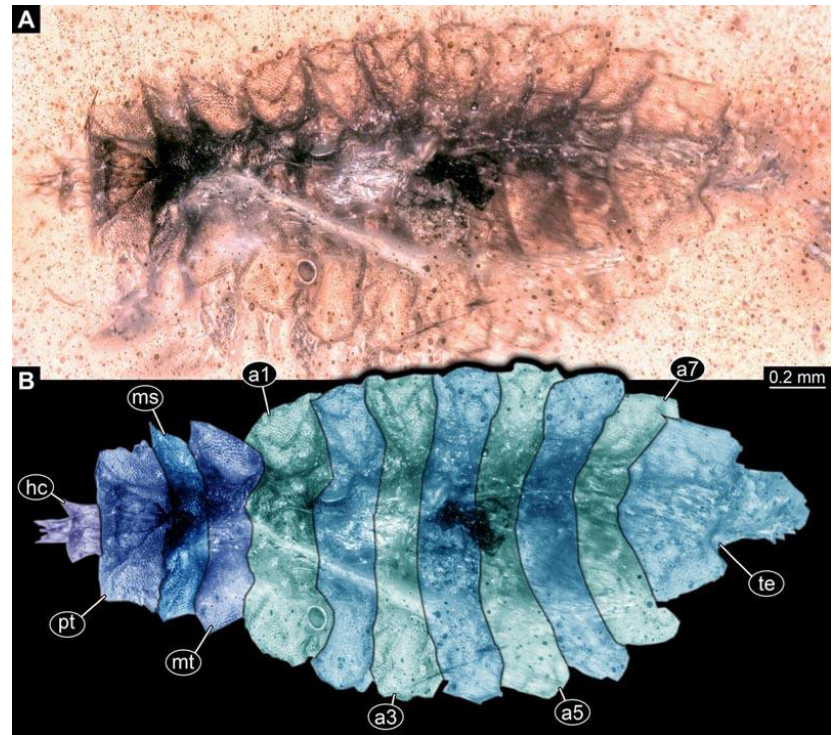
Figure 17. Fossil larva of morphotype 7, specimen PED 1218. ( A ). Dorsal view. ( B ). Colour-marked. Abbreviations: a1 – a7 = abdomen units 1 – 7; hc = head capsule; ms = mesothorax; mt = metathorax; pt = prothorax; te = trunk end. (115) PED 1295: Specimen accessible in dorsal and ventral view (Figure 18). Surface Diversity 2023 , 13 , x FOR PEER REVIEW structure apparent. Head capsule well preserved. Ventral spine-like setae well developed (Figure 18C). Paired spiracles visible on trunk end. Dimensions: body length 1.64 mm, body width 0.71 mm, head capsule length 0.18 mm, head capsule width 0.06 mm.